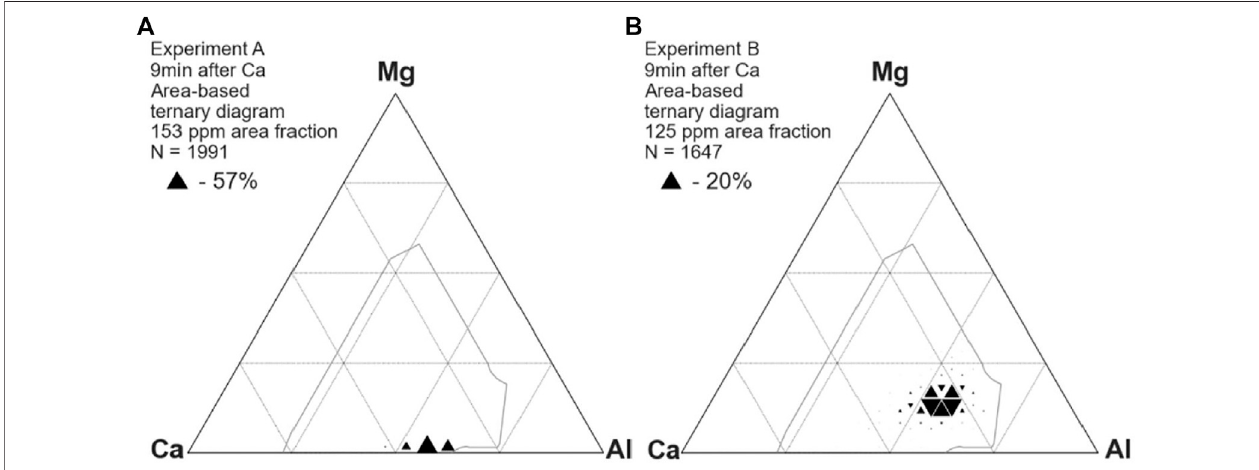
FIGURE 3 | Compositions of inclusions from experiments A (A) and B (B) after calcium treatment, showing fully modi fi ed calcium aluminates.